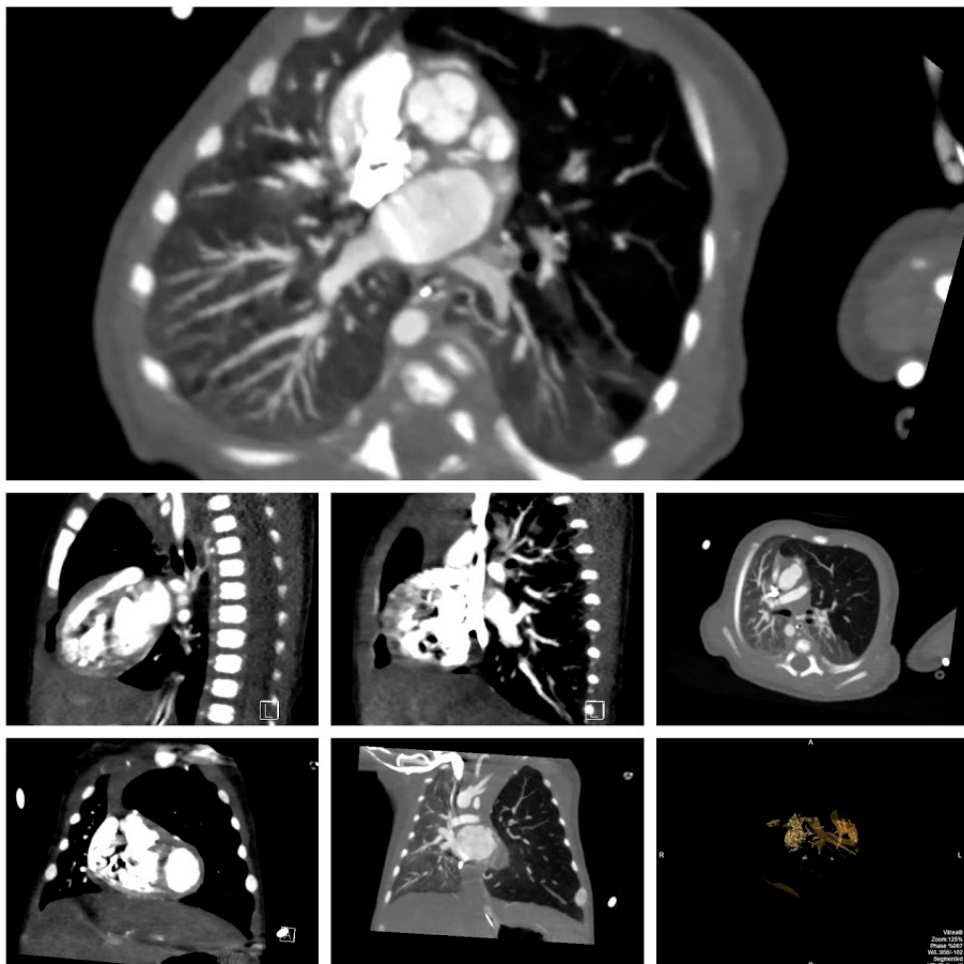
Figure 3. Multiple views on cardiac computed tomography (CT) demonstrating tertiary tracheal bronchus supplying the lingula with stenosis at the origin, double outlet right ventricle (DORV) with transposition of the great vessels, hyperinflated left upper lobe, partially atelectatic left upper and lower lobes, herniation to the right, and 3D reconstruction of airway.